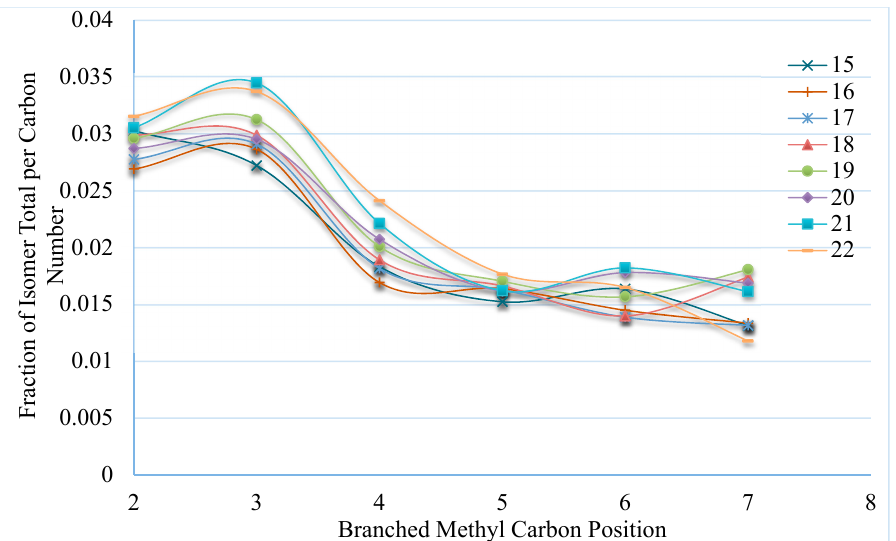
Figure 48. A graph of the single methyl branched products, arranged by carbon number, and not by the methyl group. This is a representation using a 2 K iron catalyst, where the oil was exposed to H 2 at 0.68 bar for 5 min. All of the runs at 230 °C, 12.1 bar, 0.7 H 2 /CO with a WHSV of 2.